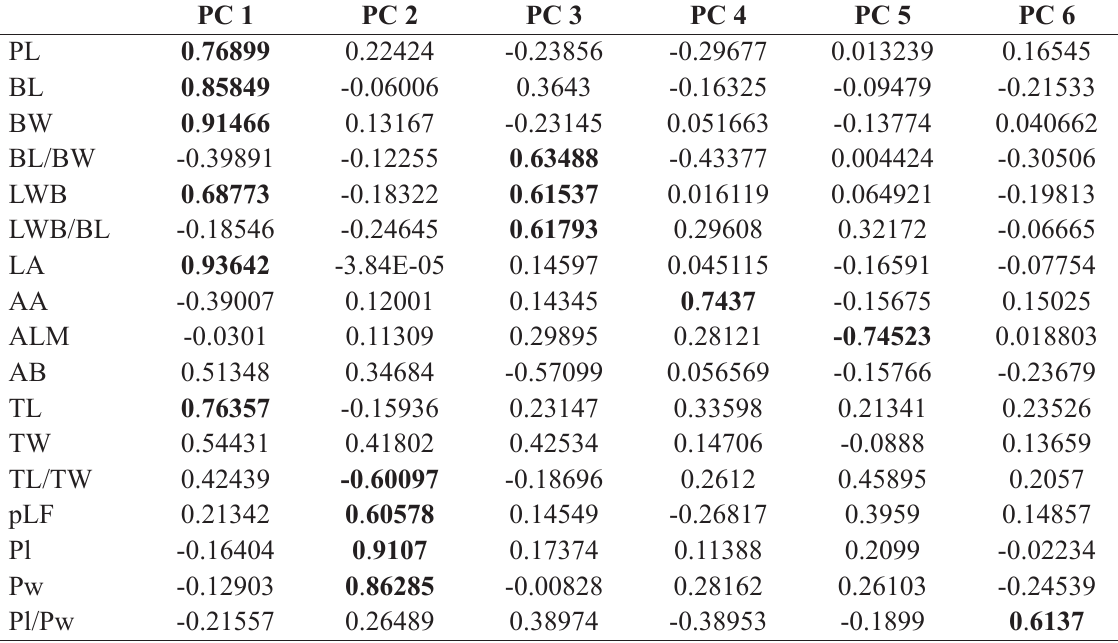
Table 3. Factor loadings for the first six principal components obtained from PCA based on 17 quantitative characters for the ‘florescence’ group of the selected species of Malus